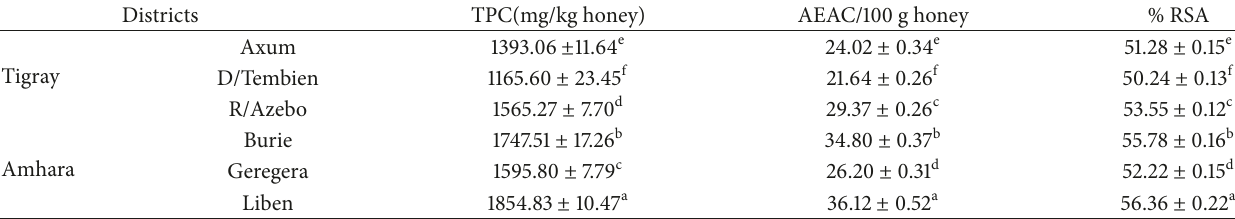
Table 2: Total phenolic content and antioxidant activity of the studied honey samples.